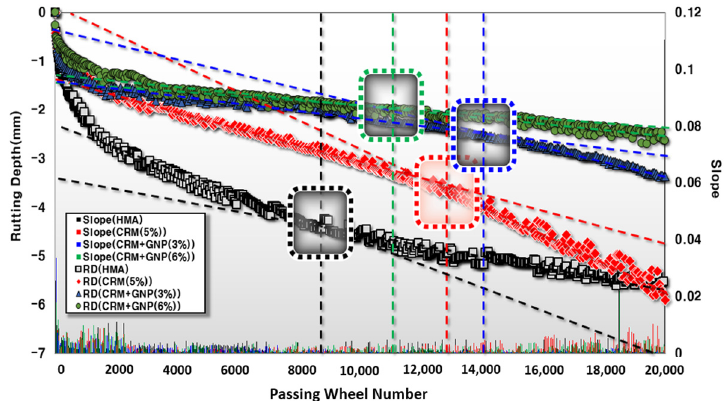
Figure 11. Hamburg wheel tracking test results.